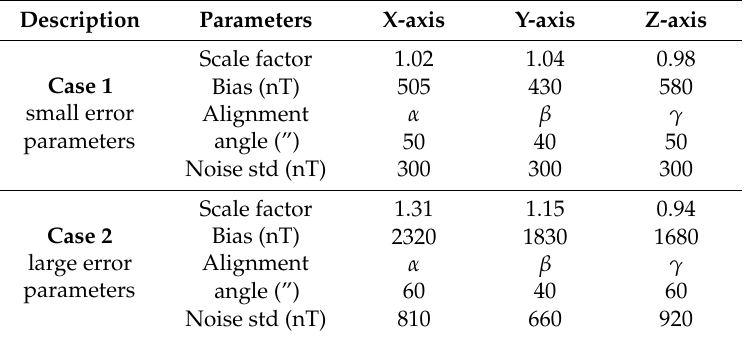
Table 1. Error parameters of magnetometer assumed in the simulation.